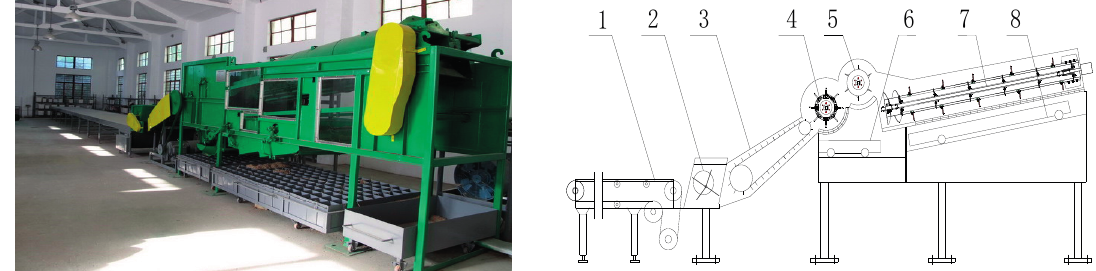
Figure 3. Schematic diagram of the axial threshing-separating-cleaning test-bench.